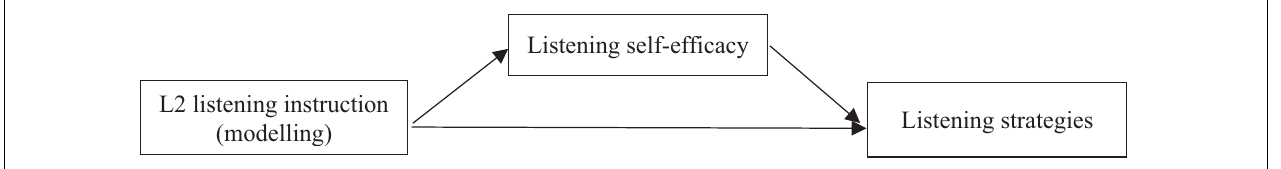
FIGURE 1 | The conceptual framework portraying the relationships among listening instruction, self-efficacy, and